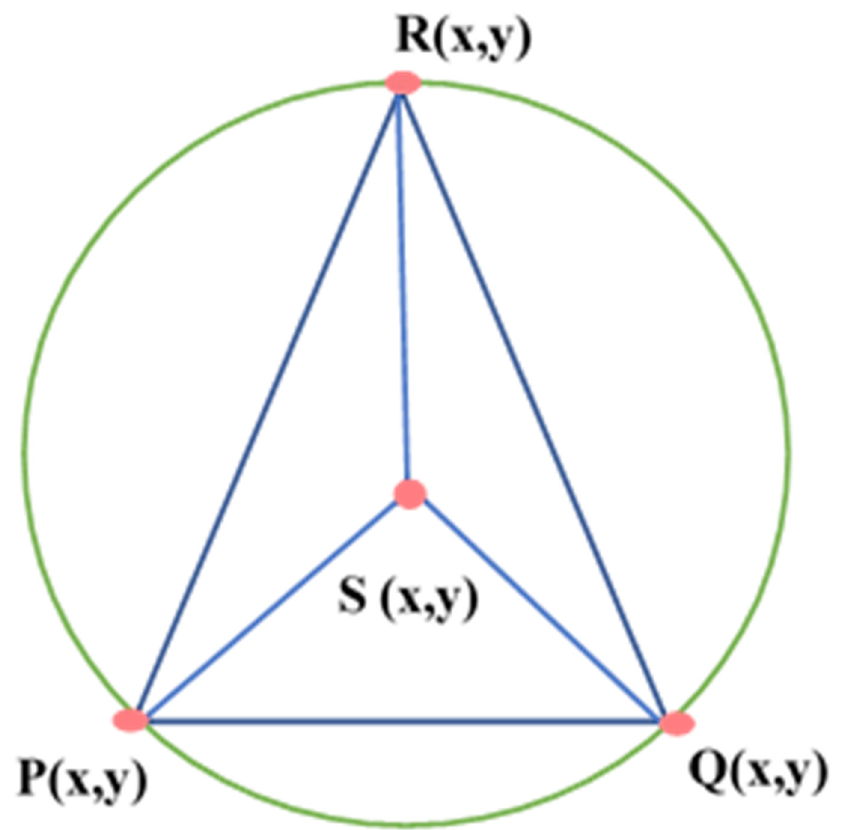
Figure 15. A representation of the empty circle property.